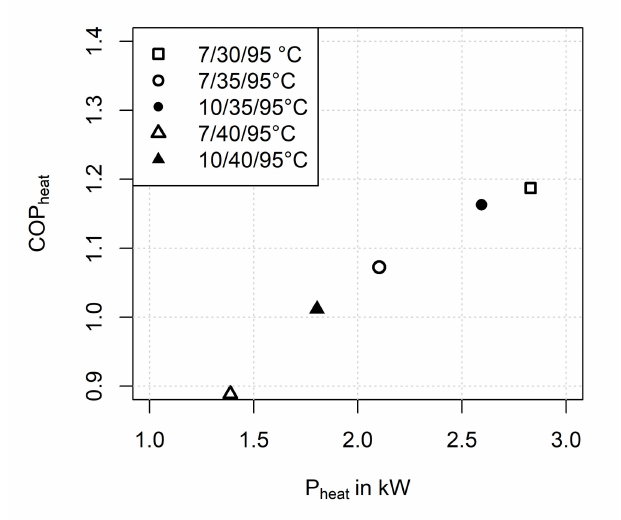
Figure 14. Efficiency and power for different temperature conditions. We show a variation of the adsorption/condensation temperature from 30 ◦ C to 40 ◦ C for an evaporator temperature of 7 ◦ C. Further, the impact of a slightly higher evaporator temperature (10 ◦ C) is shown. We conducted all measurements shown here with the same half cycle time (200 s/400 s for desorption/adsorption).